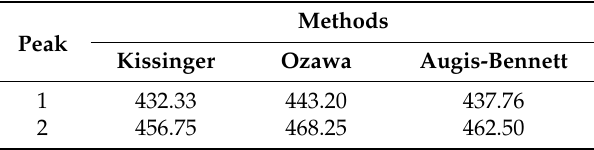
Table 2. Activation energy ( E a (kJ/mol)) of Al 82 La 10 Fe 4 Ni 4 amorphous powder for the crystallization stages determined via three methods.